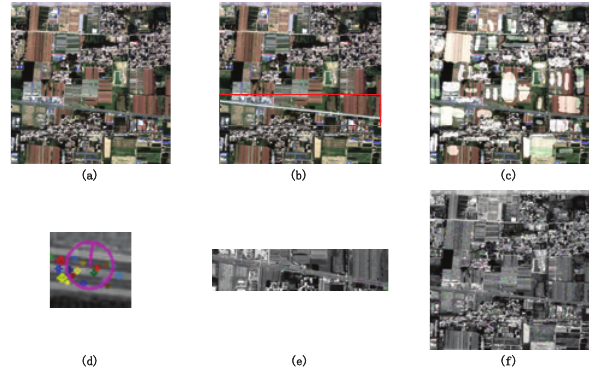
Figure 8. (a)Original image used for training classifier (b)Positive sampling range (c)Negative sampling range (d)Key point